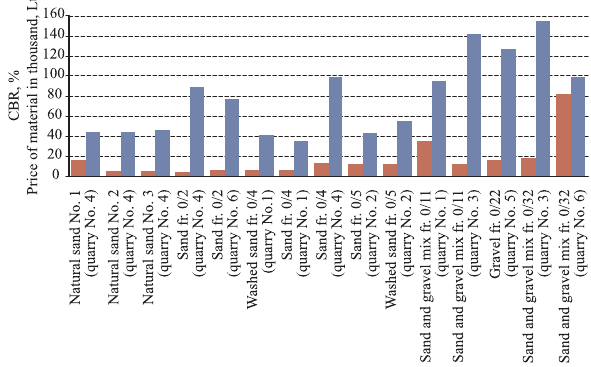
Fig. 5. Relationship between the costs of laying a 1 km long, 42 cm thick frost blanket course and CBR on the road of category III and the type (price) of material